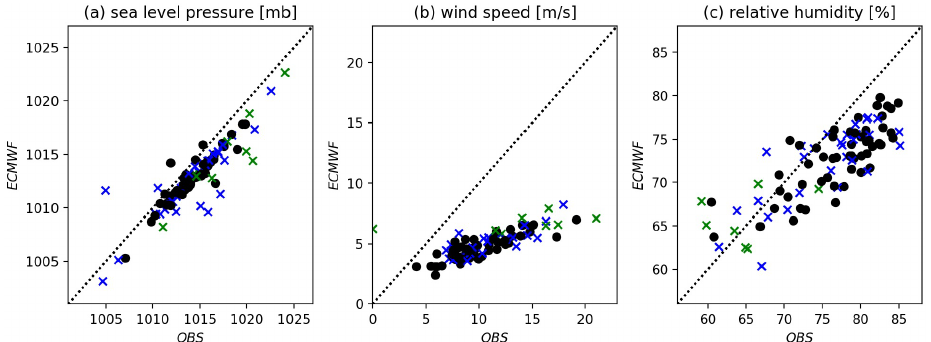
Figure 4. Comparison of the ECMWF ERA-Interim monthly averaged data of the sea level pressure (a) , wind speed at 10m (b) and relative humidity (c) and corresponding averages computed from the observations measured by the Côte d’Azur buoy near the BOUSSOLE platform. The symbols represent the different months: January to April (blue crosses), May to October (black dots) and November to December (green crosses).